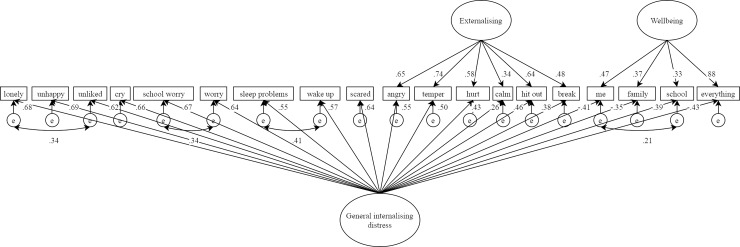
S-1internalising model results.